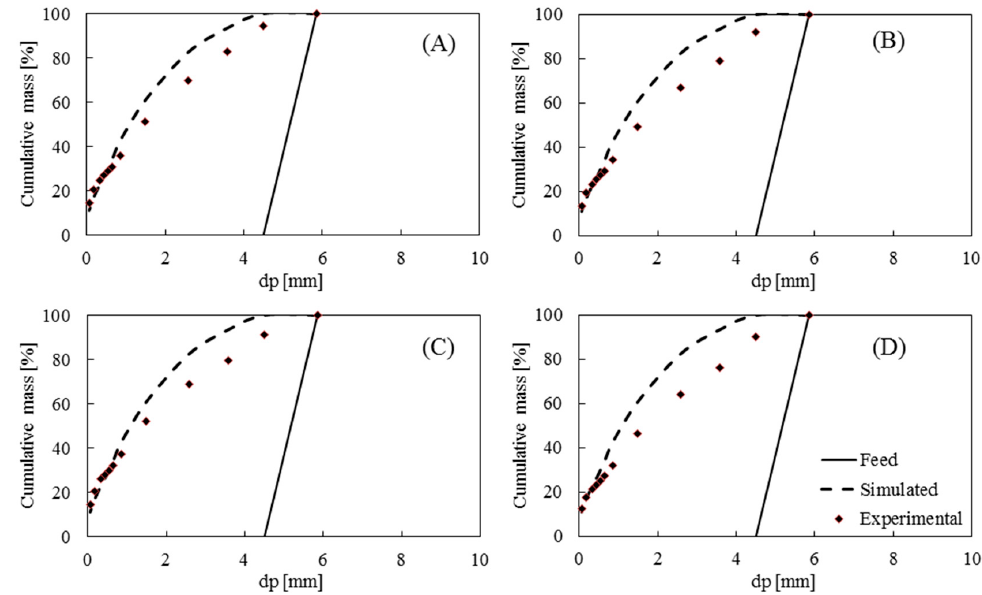
Figure 17. Feed, experimental and simulated curves using the calc-silicate material showing the effect of varying the roll speed; ( A ) MV-1; ( B ) MV-2, ( C ) M V-3 and ( D ) MV-4.